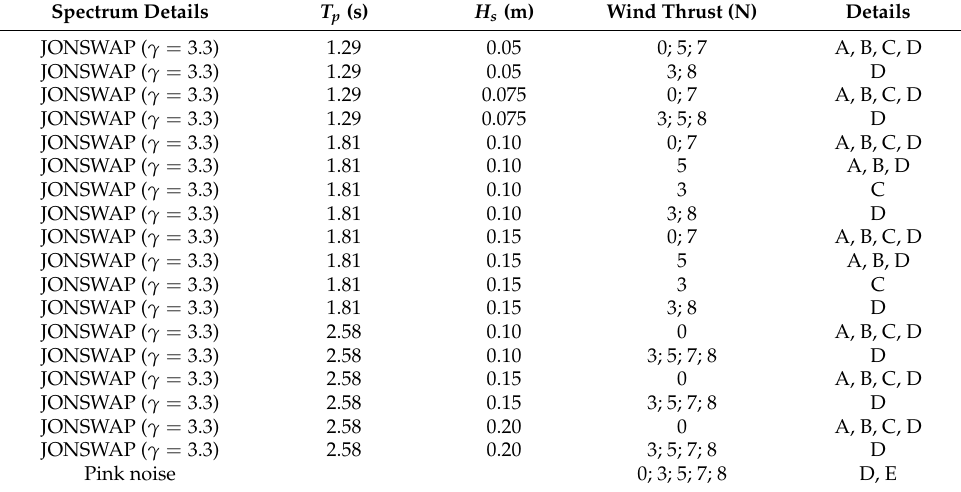
Table 3. Irregular wave list at model